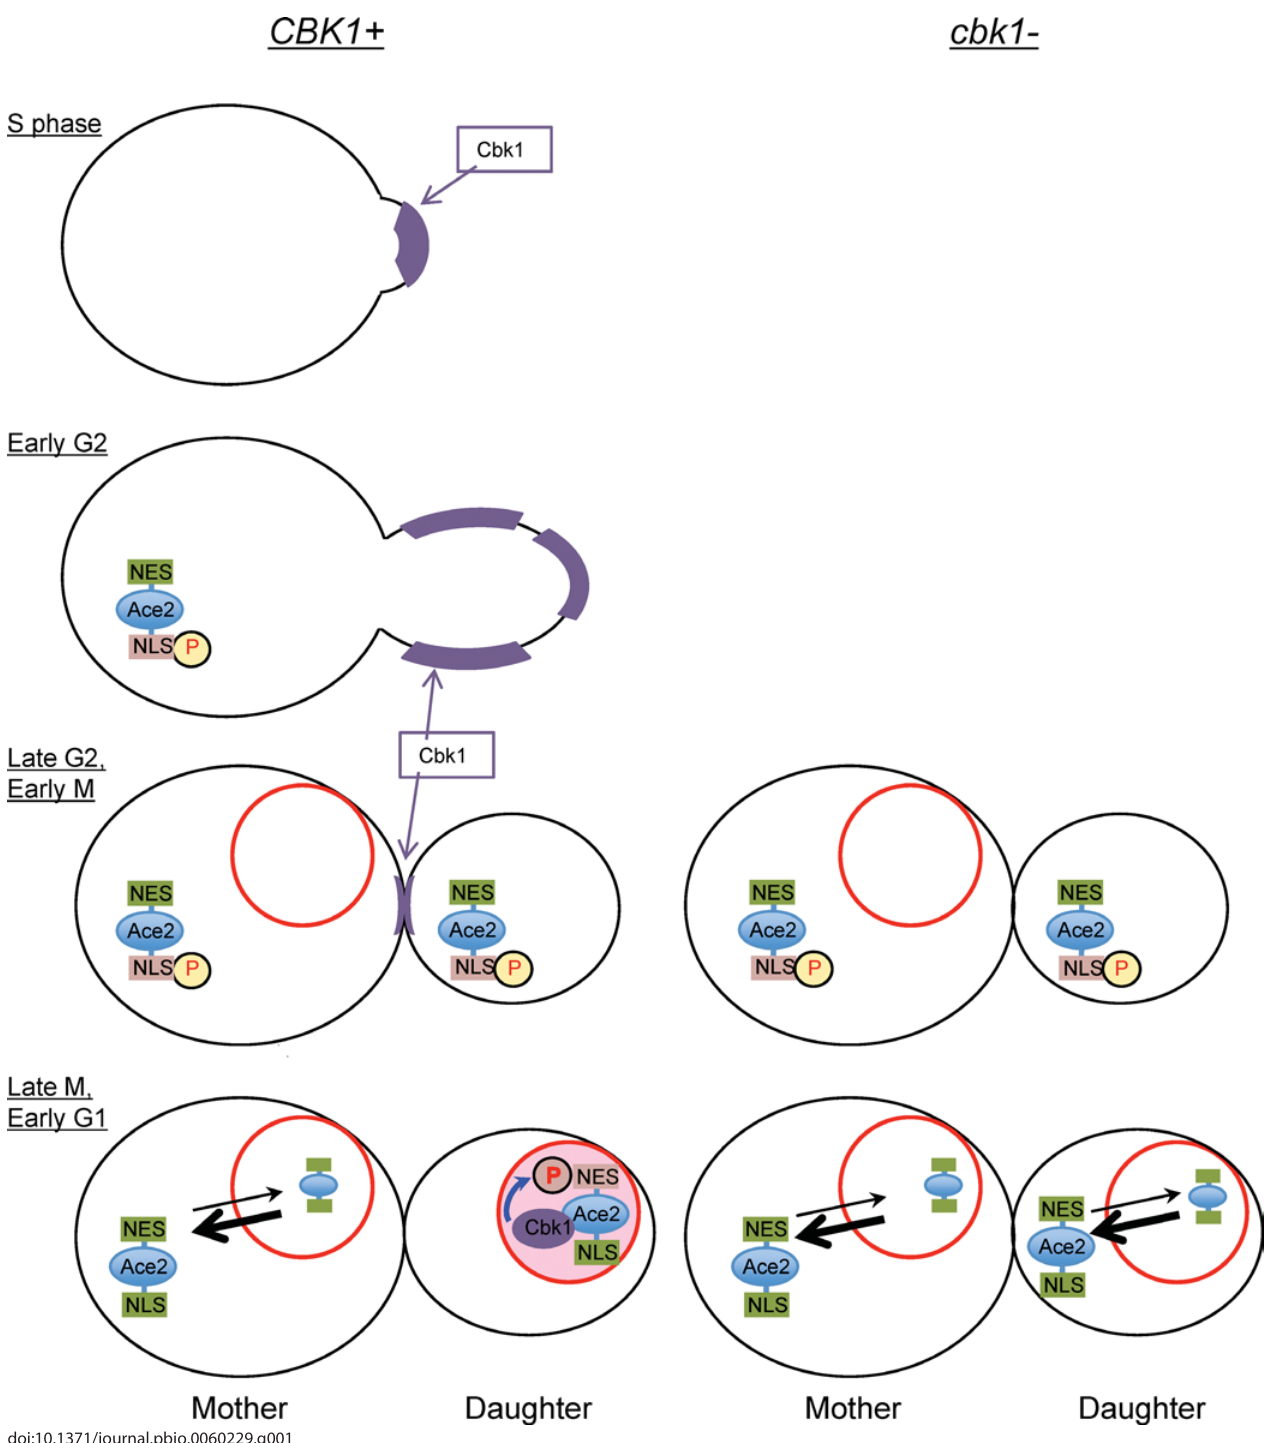
Figure 1. Ace2 Phosphorylation by Cbk1 Inactivates the NES and Allows Accumulation in the Daughter Cell Nucleus Localization of Cbk1 and Ace2 proteins at different phases of the cell cycle is shown in wild-type (left) and cbk1 mutant (right) cells. Cbk1 protein (shown in purple) is found first at the cell cortex of the incipient bud in S phase, then at the surface of the growing bud, then at the bud neck, and finally enters the nucleus of daughter cells. Nuclear accumulation by Cbk1 and Ace2 are codependent. Ace2 protein is translated in G2 phase and is retained in the cytoplasm because phosphorylation masks its NLS. In late M phase, dephosphorylation activates the NLS and the protein enters the nucleus. In mother cells, nuclear localization is transient because the NES is dominant, driving Ace2 to accumulate in the cytoplasm. In daughter cells, phosphorylation by Cbk1 inactivates the NES, and Ace2 remains in the nucleus. In cbk1 mutants, the Ace2 NES is active in mother and daughter cells, and the protein is exported from the nucleus; thus, a similar low level of Ace2 is seen transiently in both nuclei following cell